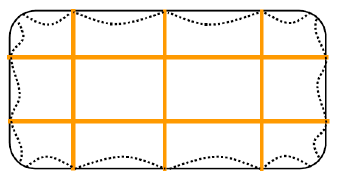
Figure 29. Design constitutive relationships of masonry: unreinforced masonry (URM) in red, confined masonry in blue [64].